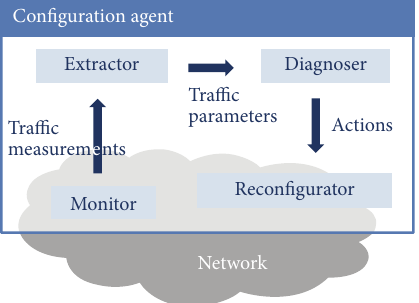
Figure 6: Configuration Agent